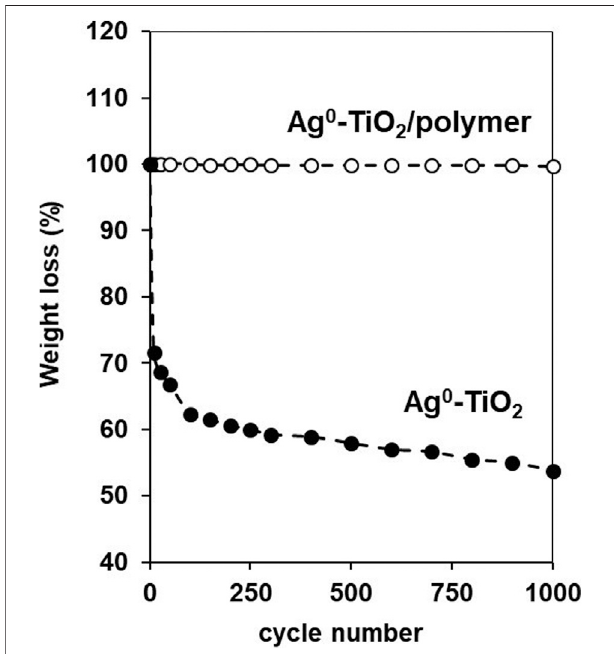
FIGURE 10 | The measured weight-loss values of Ag 0 -TiO 2 and Ag 0 - TiO 2 /polyacrylate ( (cid:1) 60:40 wt%) coatings as a function of abrasion cycle applied on